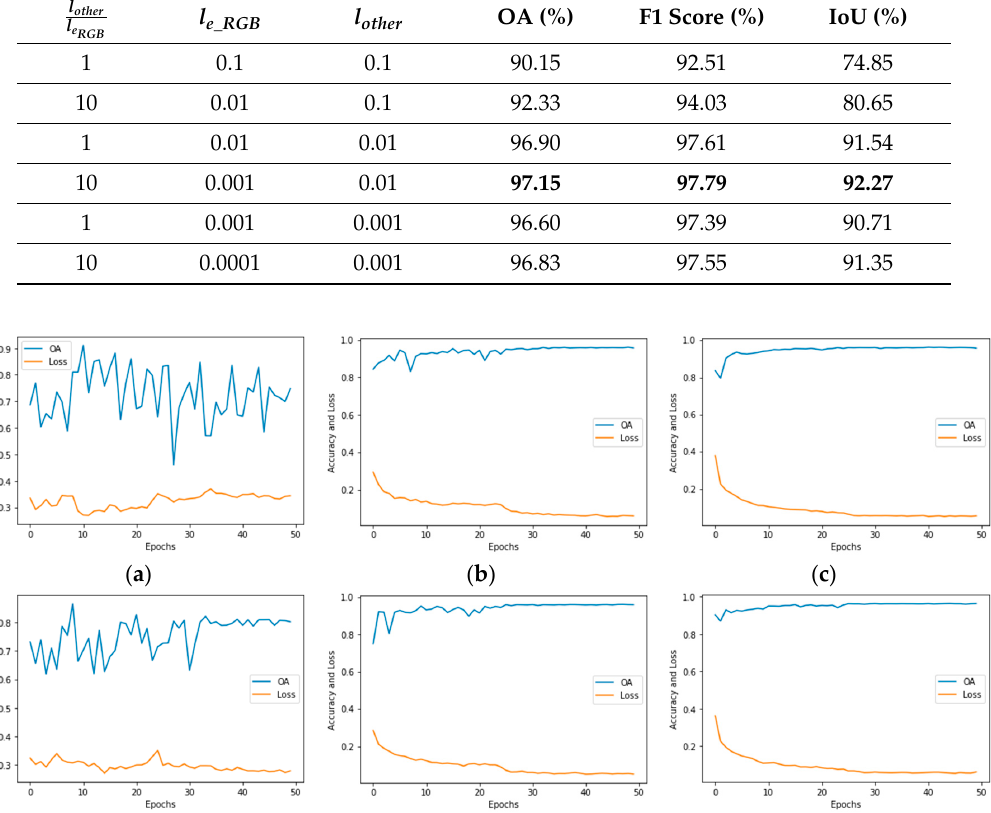
Table 2. Statistical results on the validation set with di ff erent learning rates.